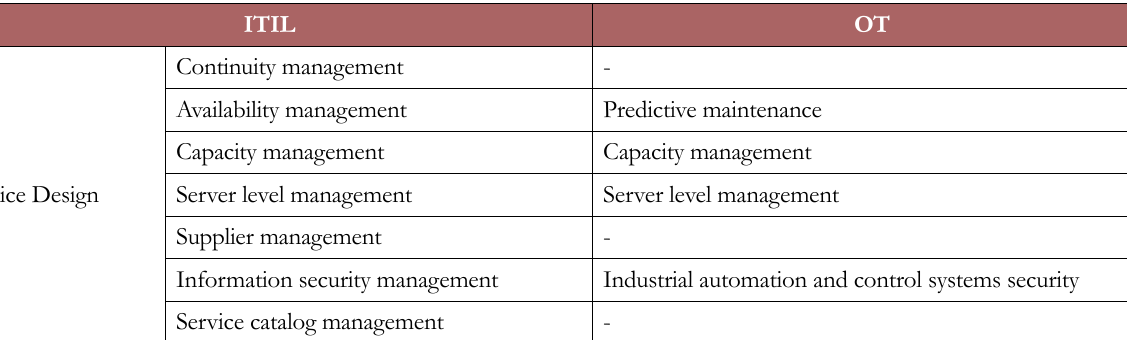
Table 4. High-level service design ITIL - OT mapping